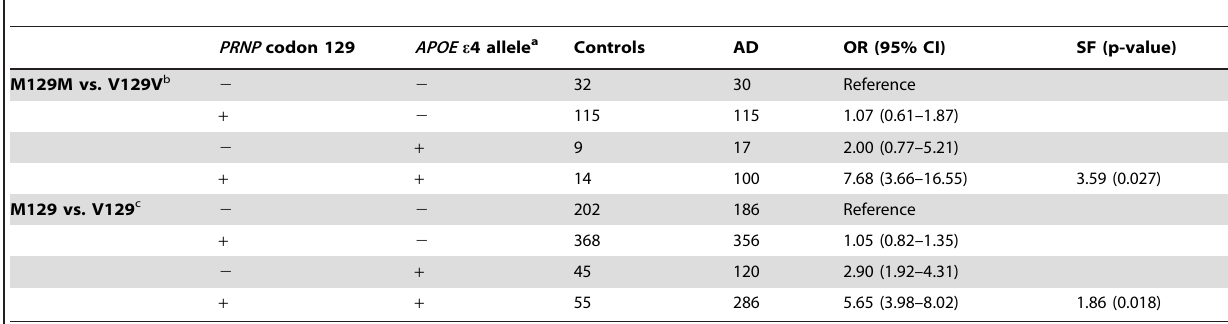
Table 4. Synergy in AD population between APOE and PRNP genes.